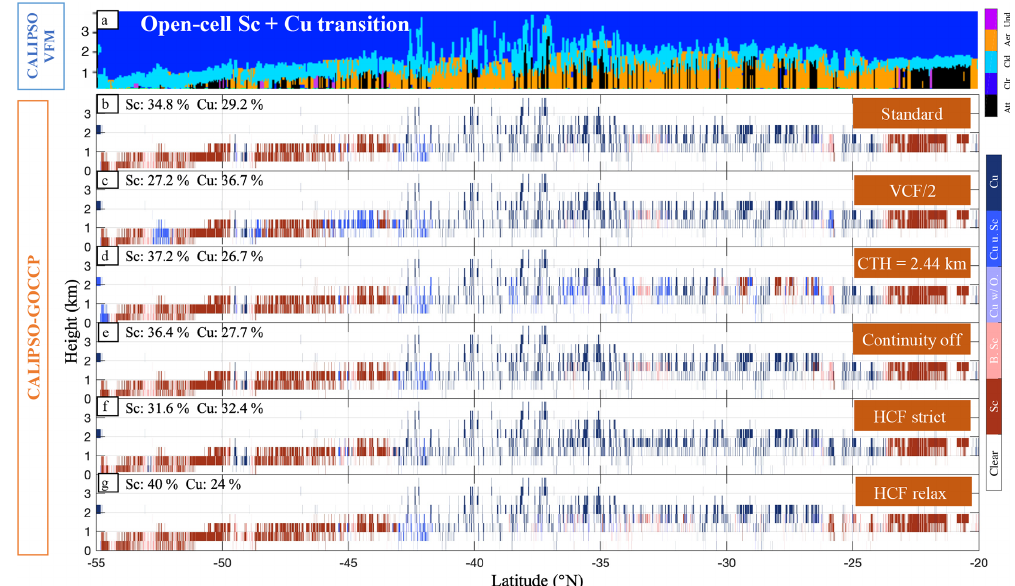
Figure 11. Same as Fig. 5 but for a typical open-cell Sc to Cu transitioning case overlapping the southeastern Pacific and the Southern Ocean ( ∼ 55 to 20 ◦ S, 14 July 2008 21:10:19,